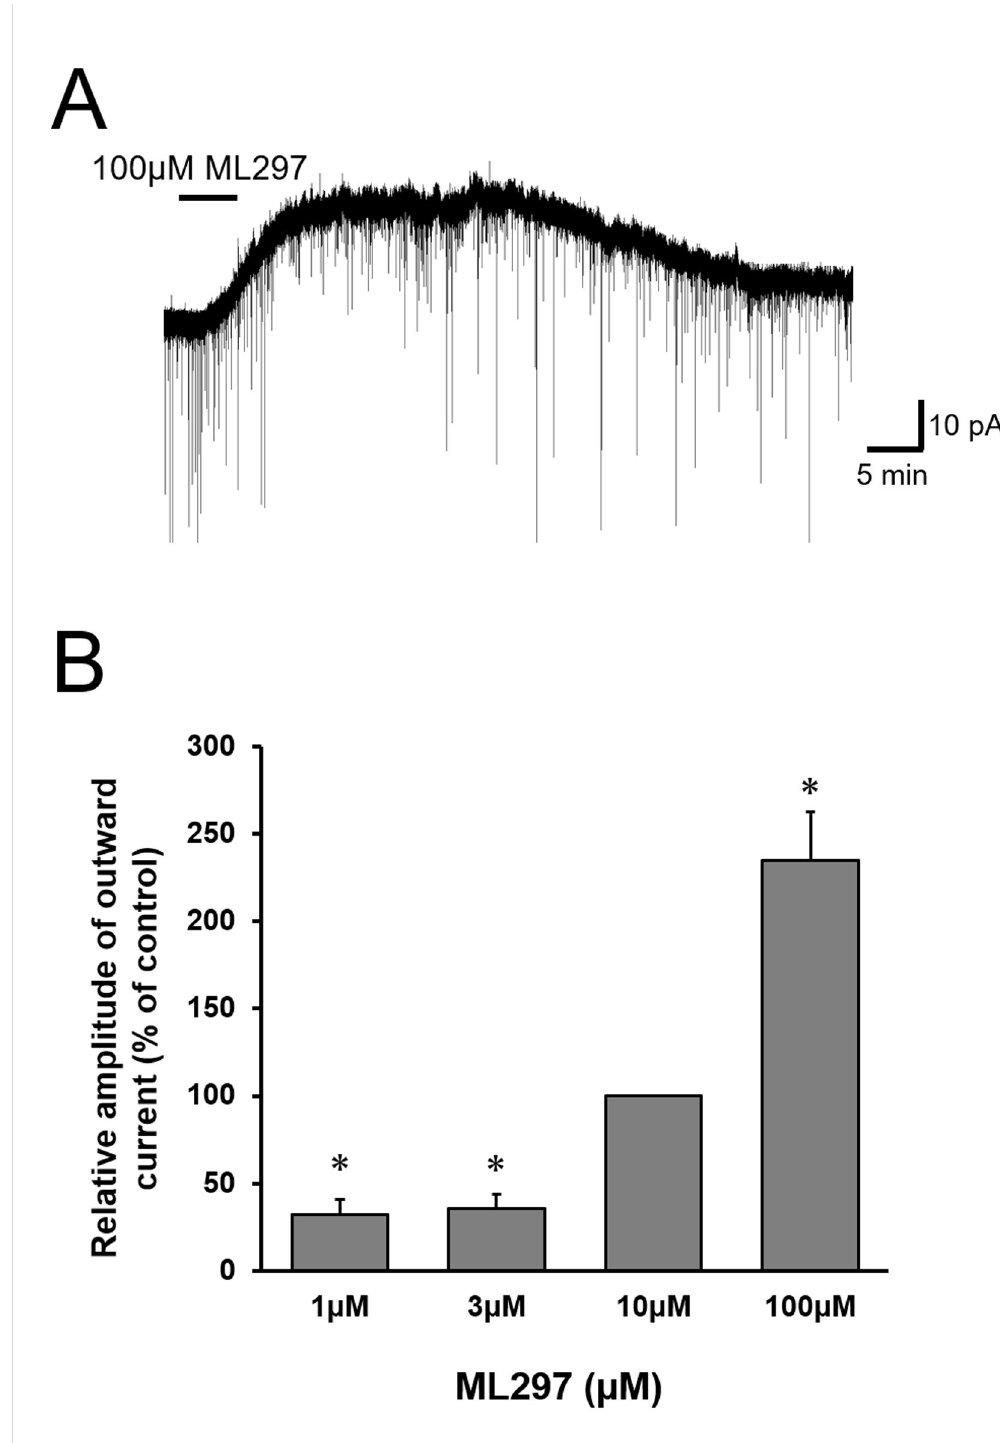
Fig 2. ML297- induced outward current in SG neurons. (A) Representative recording of 100 μ M ML297-induced outward current in voltage-clamp mode (V H = -70 mV) in a spinal cord slice preparation. (B) Correlation between the normalized amplitudes of the outward currents induced by ML297 relative to those at concentrations of 10 μ M. Data are mean ± SEM (n = 5–12). ML297 dose-dependently induced the outward current. � P < 0.0167.